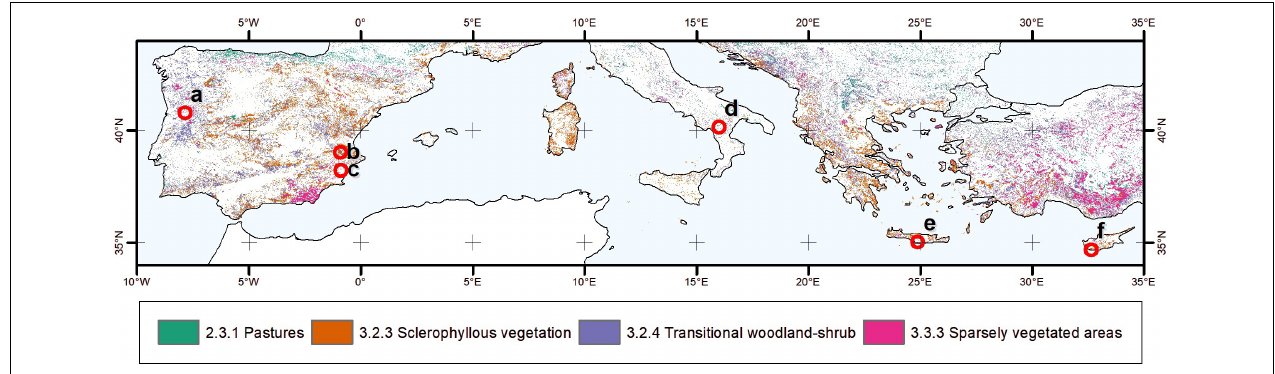
FIGURE 2 | The CASCADE study site locations (a. Várzea, b. Ayora, c. Albatera-Santomera, d. Castelsaraceno, e. Messara, f. Randi), depicted on selected land cover classes relevant to dryland ecosystems. Land cover class nomenclature adopted from CLC (2018). Figure adapted from Daliakopoulos and Tsanis (2013).